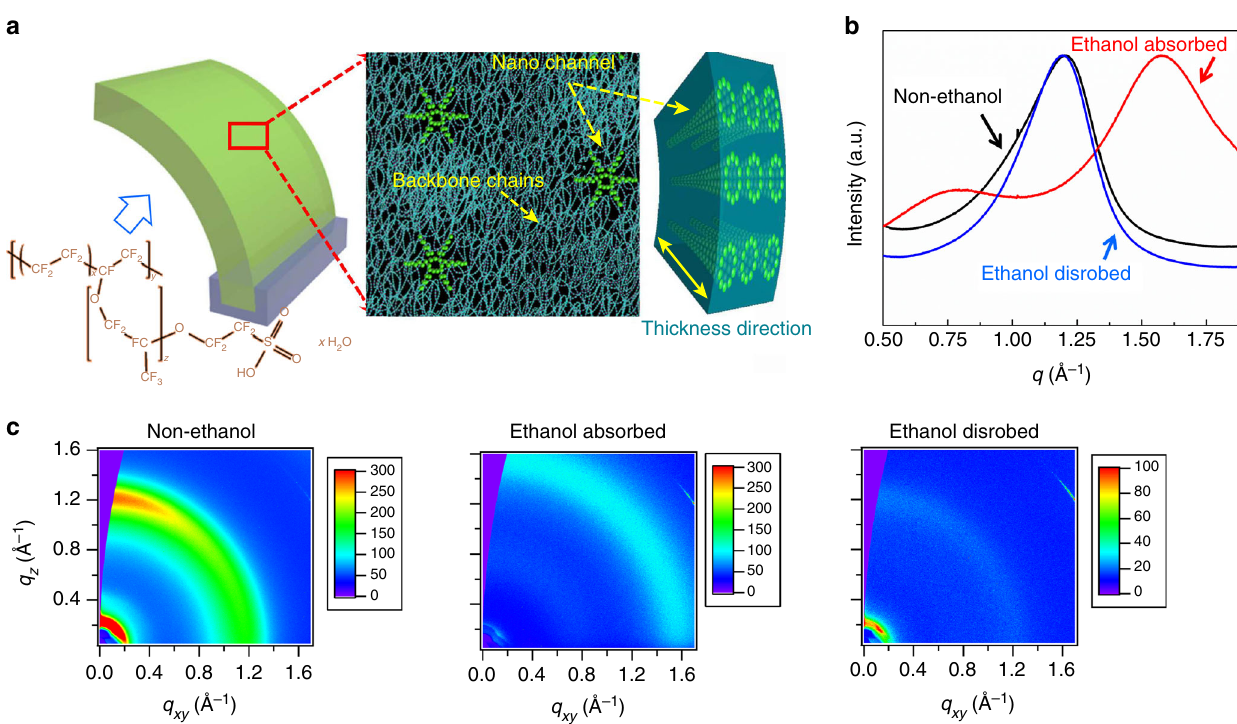
Fig. 1 PFSA microstructure and in-situ GIWAXS characterization. a Chemical structure and microstructure with molecular channel distributions. b , c The GIWAXS patterns and corresponding line-cuts from the out-of-plane direction. The nominal thickness of the sample is 232 ± 17